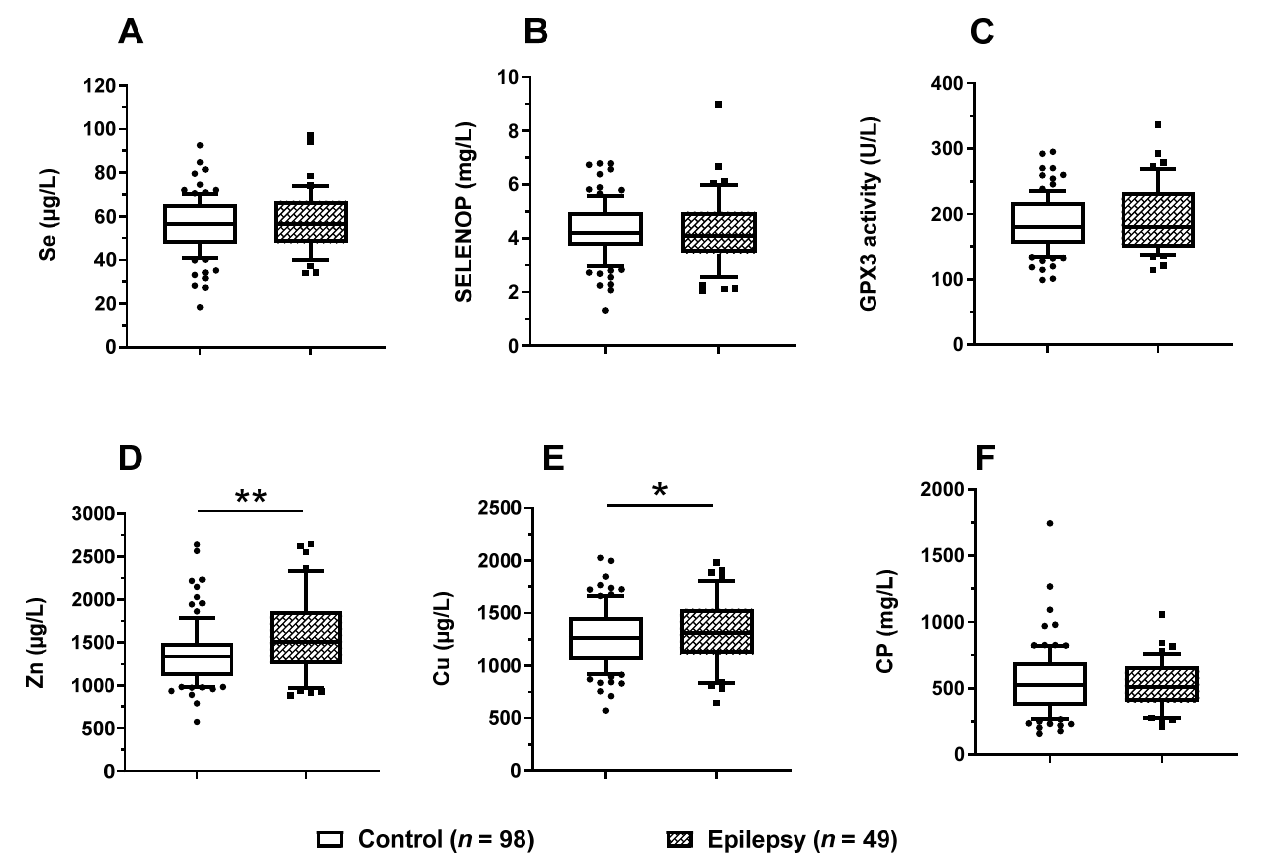
Figure 4. Comparison of serum biomarkers of TE status between paediatric patients in relation to epilepsy. All six TE biomarkers were compared between the groups of children with ( n = 49) and without ( n = 98) epilepsy. There were no significant differences in ( A ) serum Se, or ( B ) SELENOP concentrations, or ( C ) GPX3 activity between the two groups. ( D ) Serum Zn ( p = 0.004) as well as ( E ) serum Cu levels ( p = 0.023) were relatively elevated in the children with epilepsy, whereas ( F ) CP concentrations did not differ between the two groups. Data are presented as box plots (10th–90th centiles); general linear models with univariate test adjusted for age were used for analysis. p -values < 0.05 were considered statistically significant. ** indicates p < 0.01, and * indicates p < 0.05.